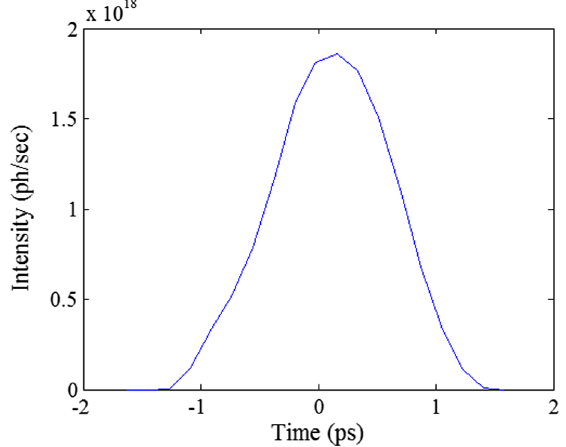
FIG. 7. Plot of the simulated time duration of the x-ray pulse at 12 keV. The time duration is nearly equal to the electron bunch length and does not depend on the laser pulse length. The figure shown is without compression: electron bunch compression would produce significantly shorter pulses.